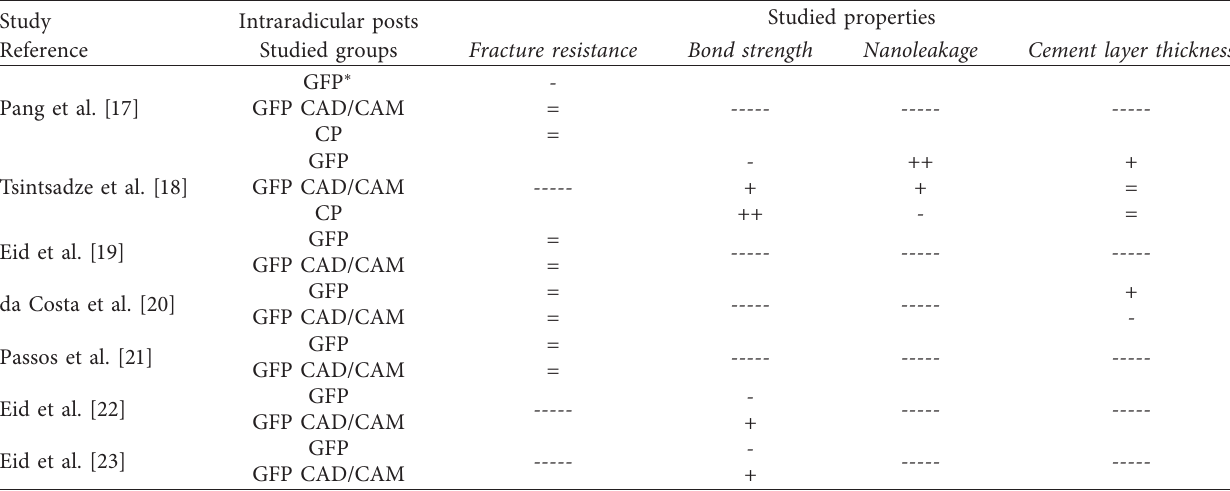
Table 5: Results of the 7 included studies according to the groups studied and their comparative